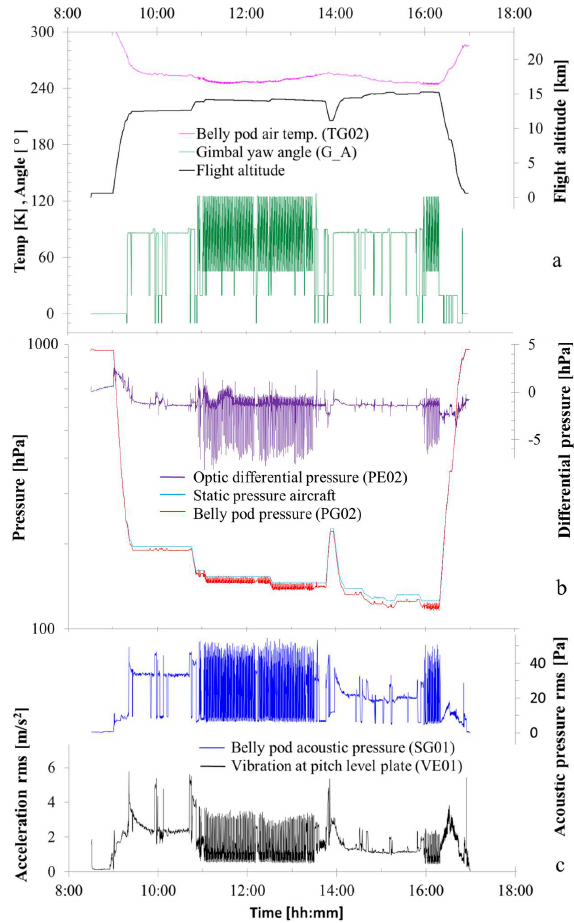
Figure 11. Ambient conditions of GLORIA during flight 8 on HALO on 28 August 2012: (a) belly pod air temperature (pink), flight altitude (black), and gimbal yaw angle (green), (b) optic dif- ferential pressure (purple), static pressure aircraft (light blue), and belly pod pressure (red), and (c) belly pod acoustic pressure (blue) and spectrometer vibrations (black).